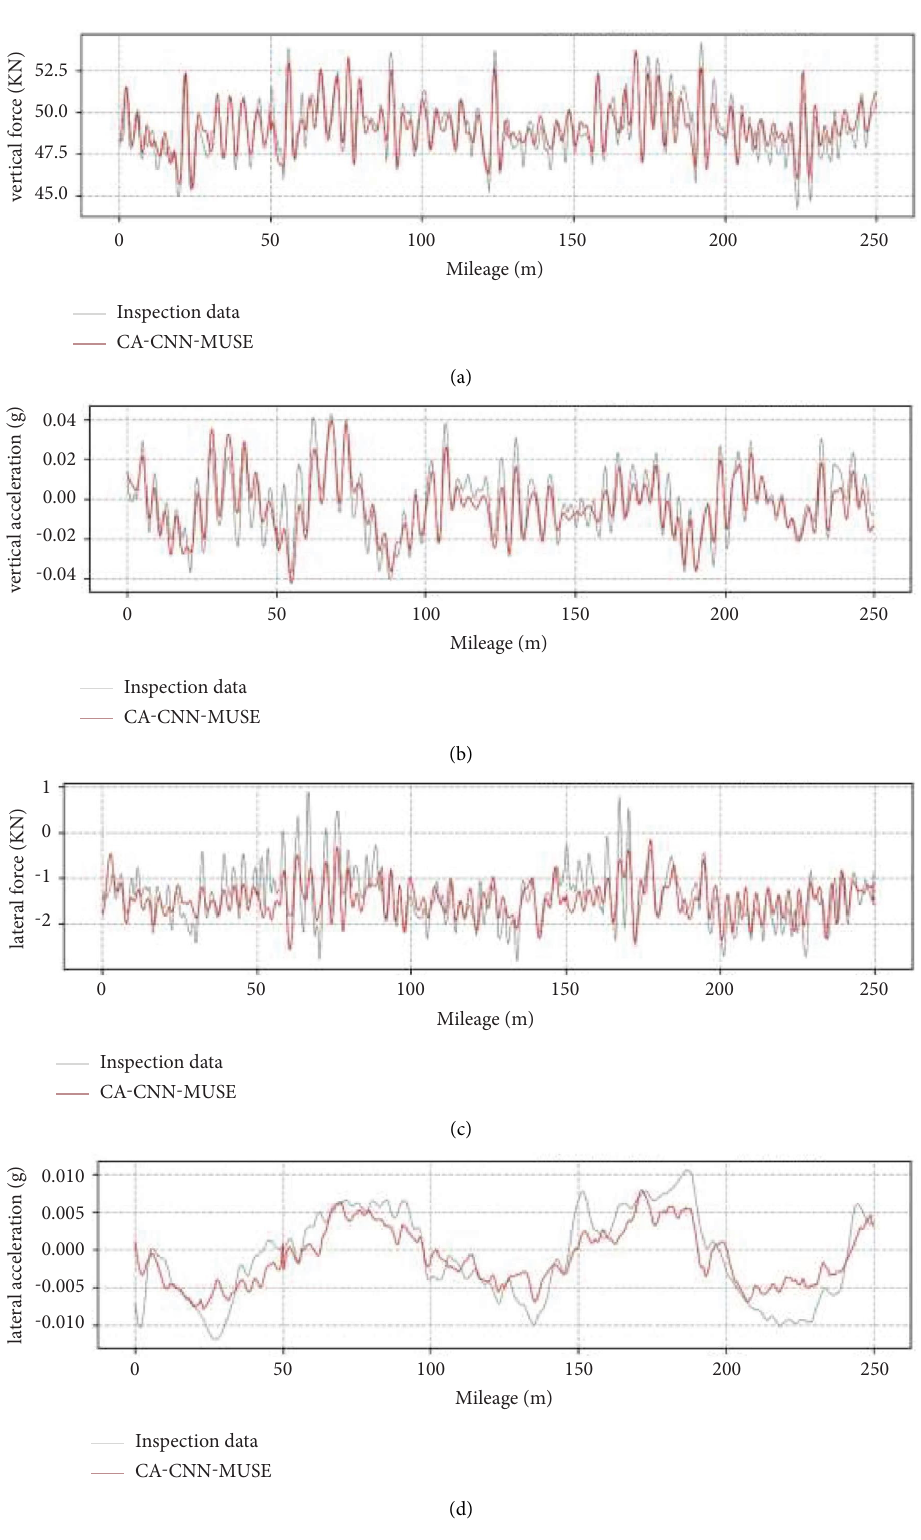
Figure 3: Waveforms of vehicle responses. (a) Right vertical force, (b) vertical car body acceleration, (c) right lateral force, and (d) lateral car body